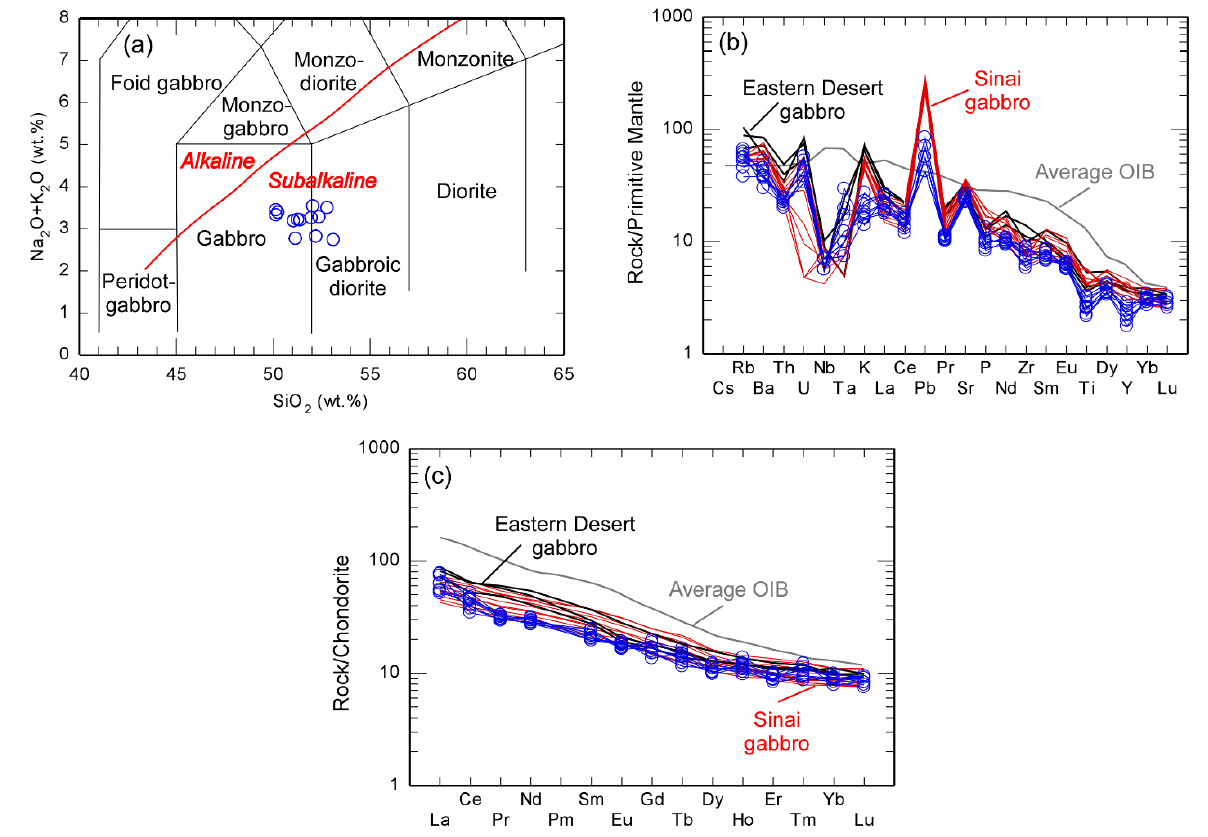
Figure 5. ( a ) Total alkalis vs. SiO 2 [43]. The red line separates alkaline and subalkaline compositions adopted from Irvine and Baragar [44]; ( b ) primitive mantle-normalized trace element patterns; and ( c ) chondrite-normalized REE patterns. Normalization values and average OIB are from Sun and McDonough [45]. Post-collisional gabbros from the Eastern Desert and southeast Sinai in the ANS were used for comparison [10,46].